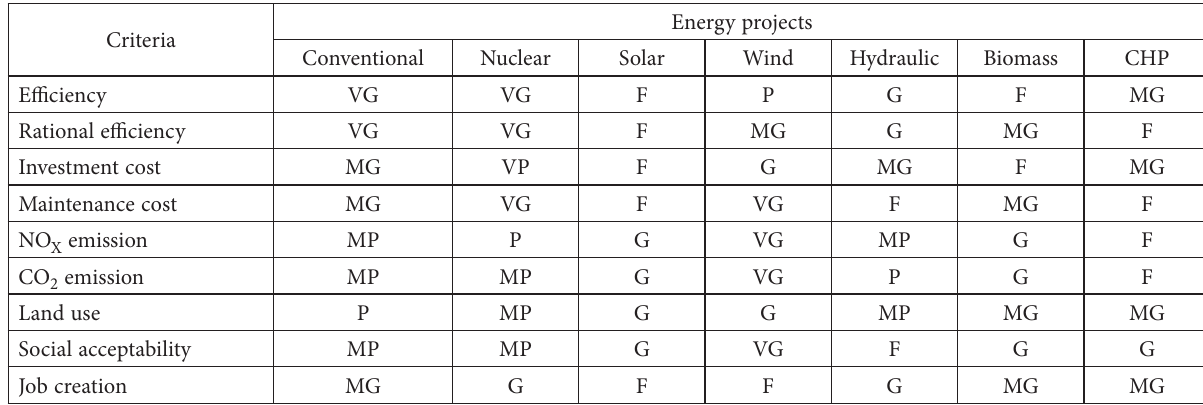
Table 4. Judgment matrix of DM3